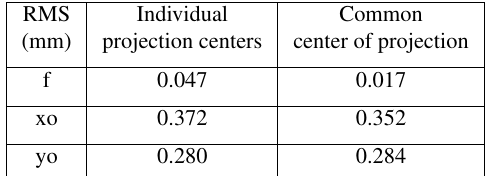
Figure 9. Scheme of formation of the simulated images. Random errors were added to image coordinates with std.error of 0.01mm and to test-object points with std.error of 1mm. 10 realizations were done. The results (RMS of deviations from true values in mm) are shown in the Table 1.